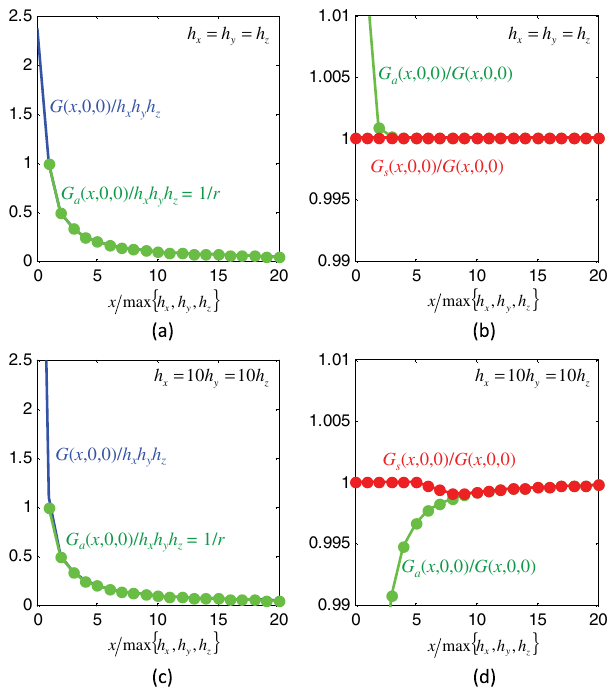
FIG. 3. The Green ’ s function G , the asymptotic approximation G and the “ switched ” approximation G for switch parameters a s C 2 ¼ 2 C 1 ¼ 10 : (a) and (c) comparison of G and its asymptotic =G and G =G ; (a) and ; (b) and (d) ratios G approximation G p a s (b) for cubic mesh cells; (c) and (d) for mesh cells with large 10 h 10 h aspect ratio ( h ). The Green ’ s function is only x ¼ y ¼ z calculated for discrete mesh points ( x ¼ nh x